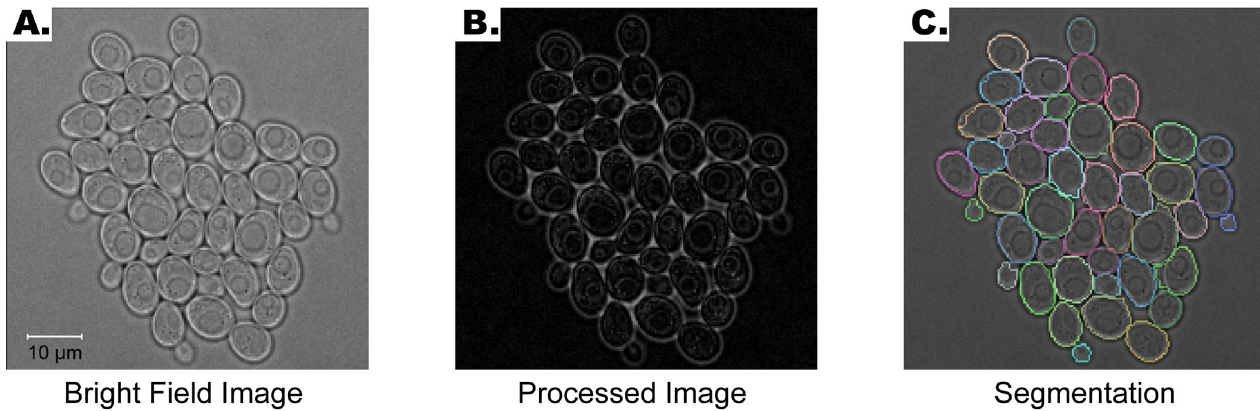
Fig 9. Segmentation of bright-field images. (A) Example bright-field image. (B) Bright-field image is processed before segmentation by applying a top-hat transform to its complement. (C) Segmentation of the image. Each cell boundary is marked with a different color.